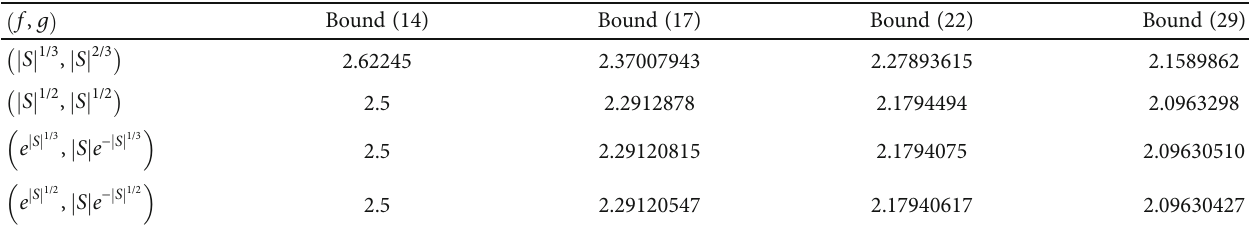
Table 2: Bounds (14), (17), (22), and (29) for di ff erent choices of f and g in